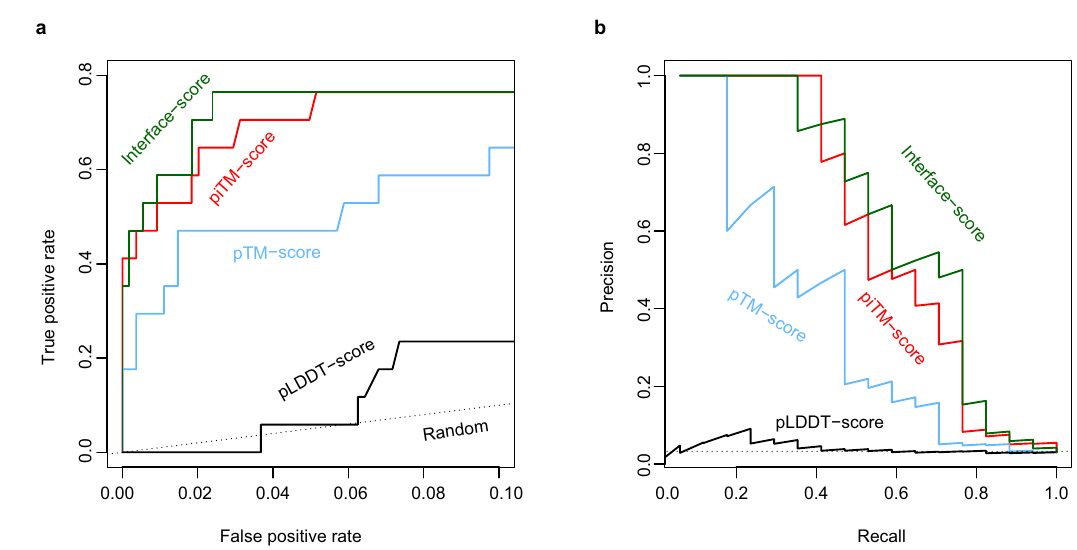
Fig. 4 Identi fi cation of true interacting protein pairs in the all-against-all pool for the CP17 set by various con fi dence metrics. a Receiver operating characteristic curve and ( b ) the precision-recall curve. The random curve is the expected result by randomly guessing interacting protein pairs. piTM-, pTM- and pLDDT-score denote predicted interface TM-score, predicted TM-score, and predicted local distance difference test score, respectively.